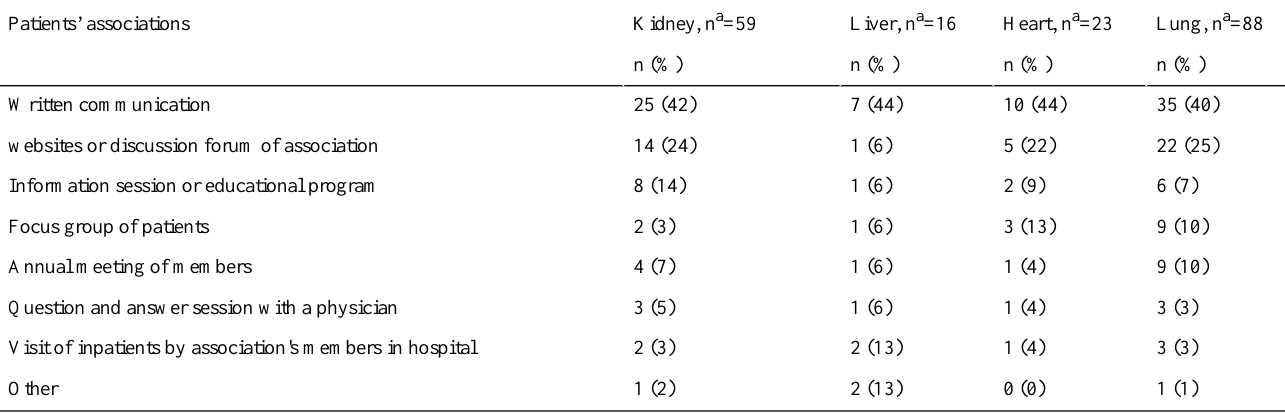
Table 4. Distribution of information sources provided by associations for patients of each type of transplantation ( P